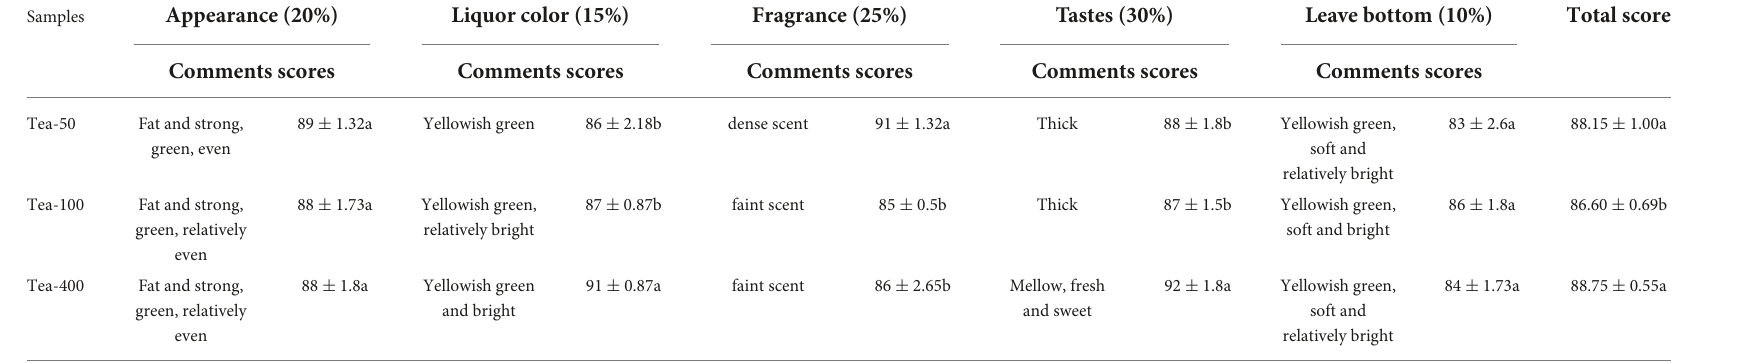
TABLE 5 Results of sensory quality evaluation of dried tea samples of different ages in group